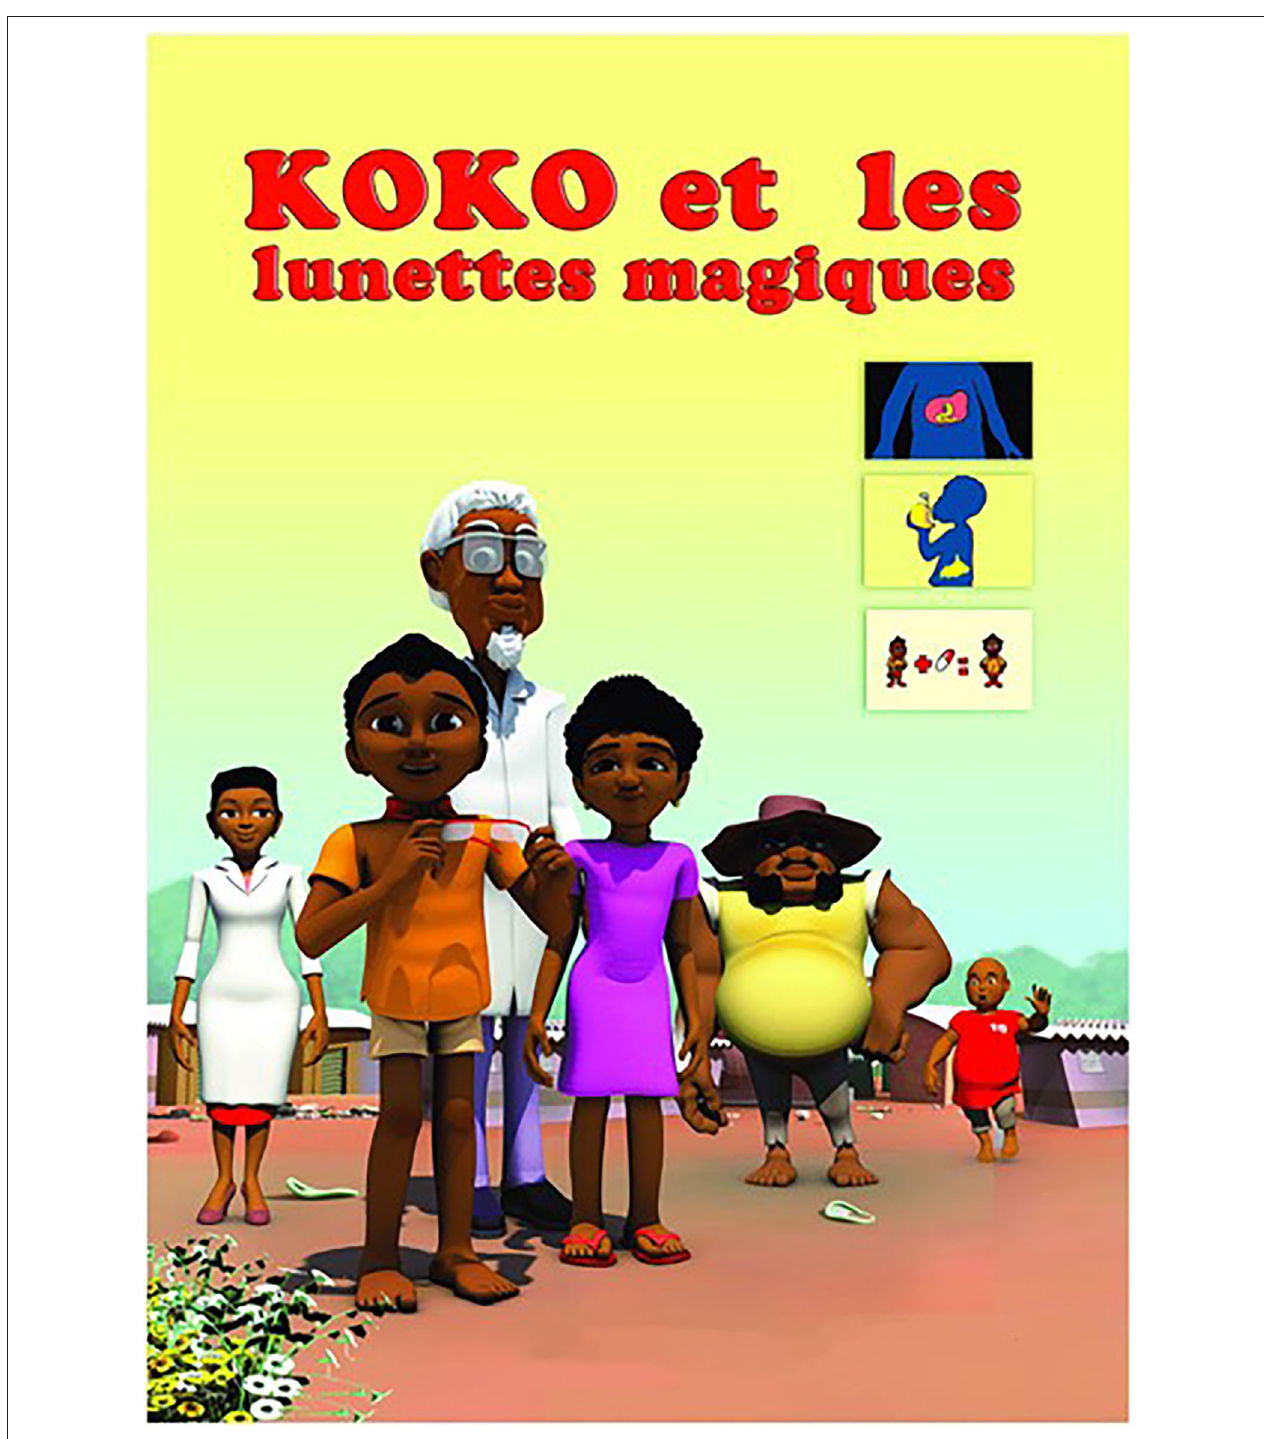
FIGURE 3 | Koko et les lunettes magiques